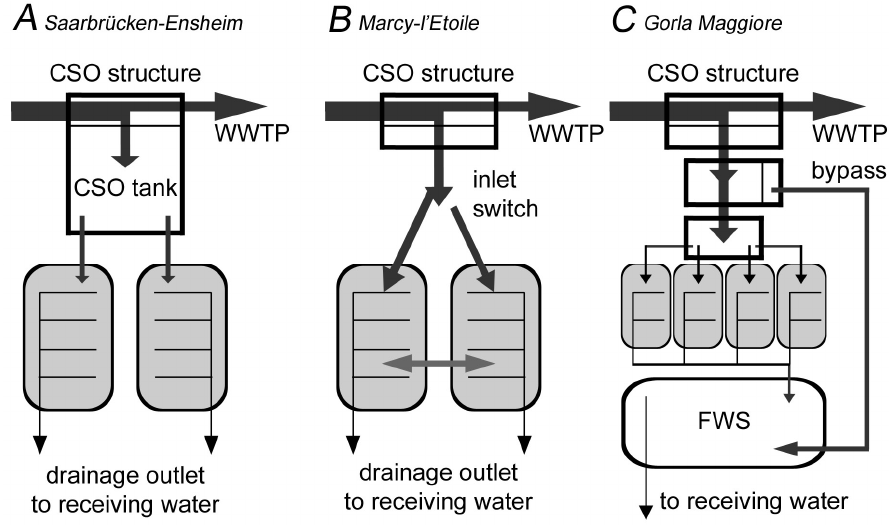
Figure 1. Simplified system sketch for in ( A ) retention soil filters in Germany; and ( B ) combined sewer overflow constructed wetlands in France; and ( C )